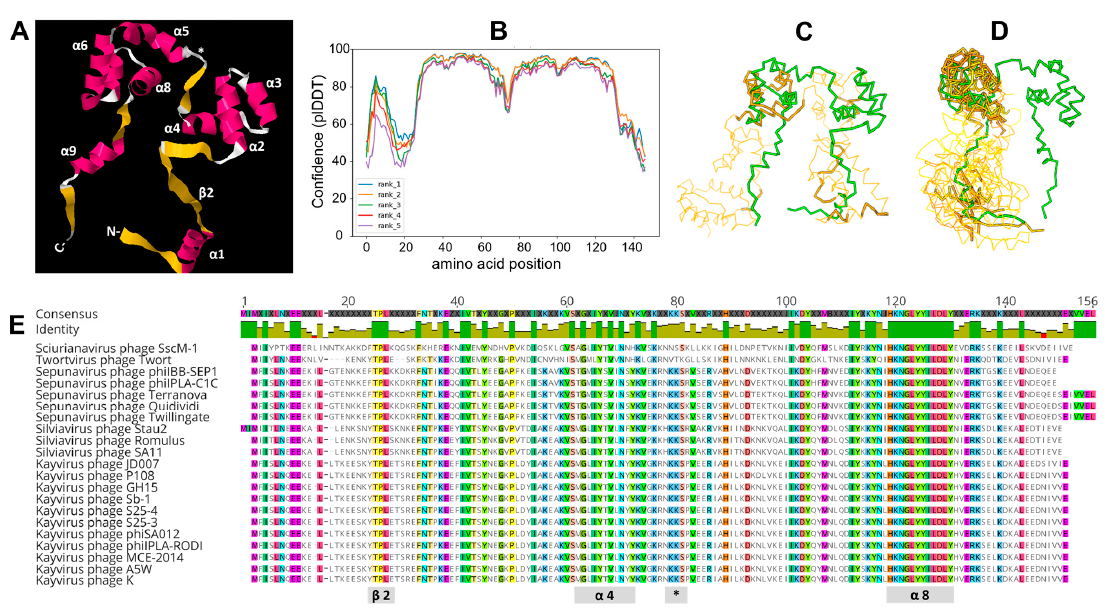
Figure 7. Molecular modeling of Gp102 and structurally similar proteins in other organisms. ( A ) a representative prediction of phage K Gp102 by AlphaFold2, showing pink α -helices (numbered from the N-terminus) and yellow β -strands. ( B ) AlphaFold2 prediction confidence (predicted local distance difference test) by position for the five best predicted structures. The HTH domains are predicted to have high accuracy (pIDDT > 90), regions with plDDT between 70 and 90 have good accuracy, and the terminal “arms” of the protein have low confidence (plDDT < 70) or might only have structure as part of a complex (pLDDT < 50) [CITATION]. ( C ) DALI output showing the superposition of phage K Gp102 (green) and S. pombe Reb1 (gold) [Z = 4.5, rmsd = 14.8, lali = 80, %id = 9]. ( D ) DALI output showing superposition of phage K Gp102 (green) and S. aureus proteins VraR (RCSB#GVB4), NreC (RCSB#GV7J), a putative DNA- binding response regulator (RCSB#GWVB), and an uncharacterized protein (RCSB#GV5T) [Z = 4.0–4.5, rmsd = 9.3–11.3, lali = 61–63, %id = 13–16]. ( E ) ClustalOmega protein alignment of representative Gp102 homologs across the Twortvirinae subfamily, highlighting residues that are conserved in ≥ 90% of the displayed sequences. Selected protein regions are mapped to the secondary structures in panel A.